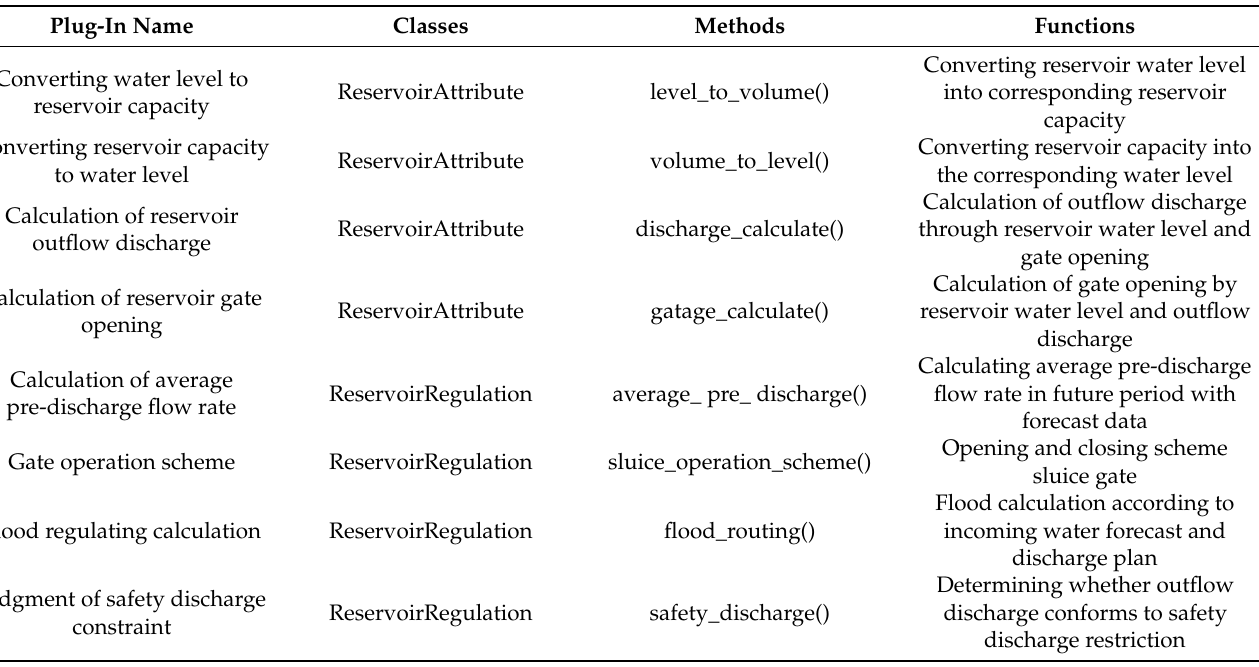
Table 4. Reservoir plug-in creation.